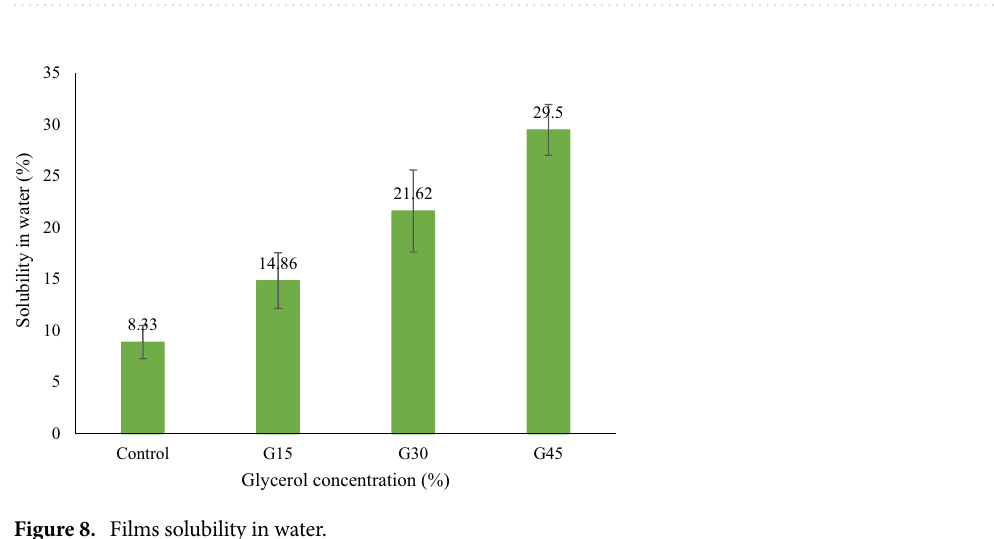
Figure 7. The moisture content of AS film with different glycerol concentrations.